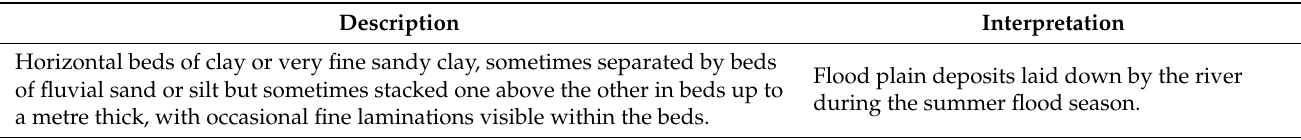
Table 3. Depositional environments and associated sedimentary facies in the Nile valley. For further details, see [52–54].